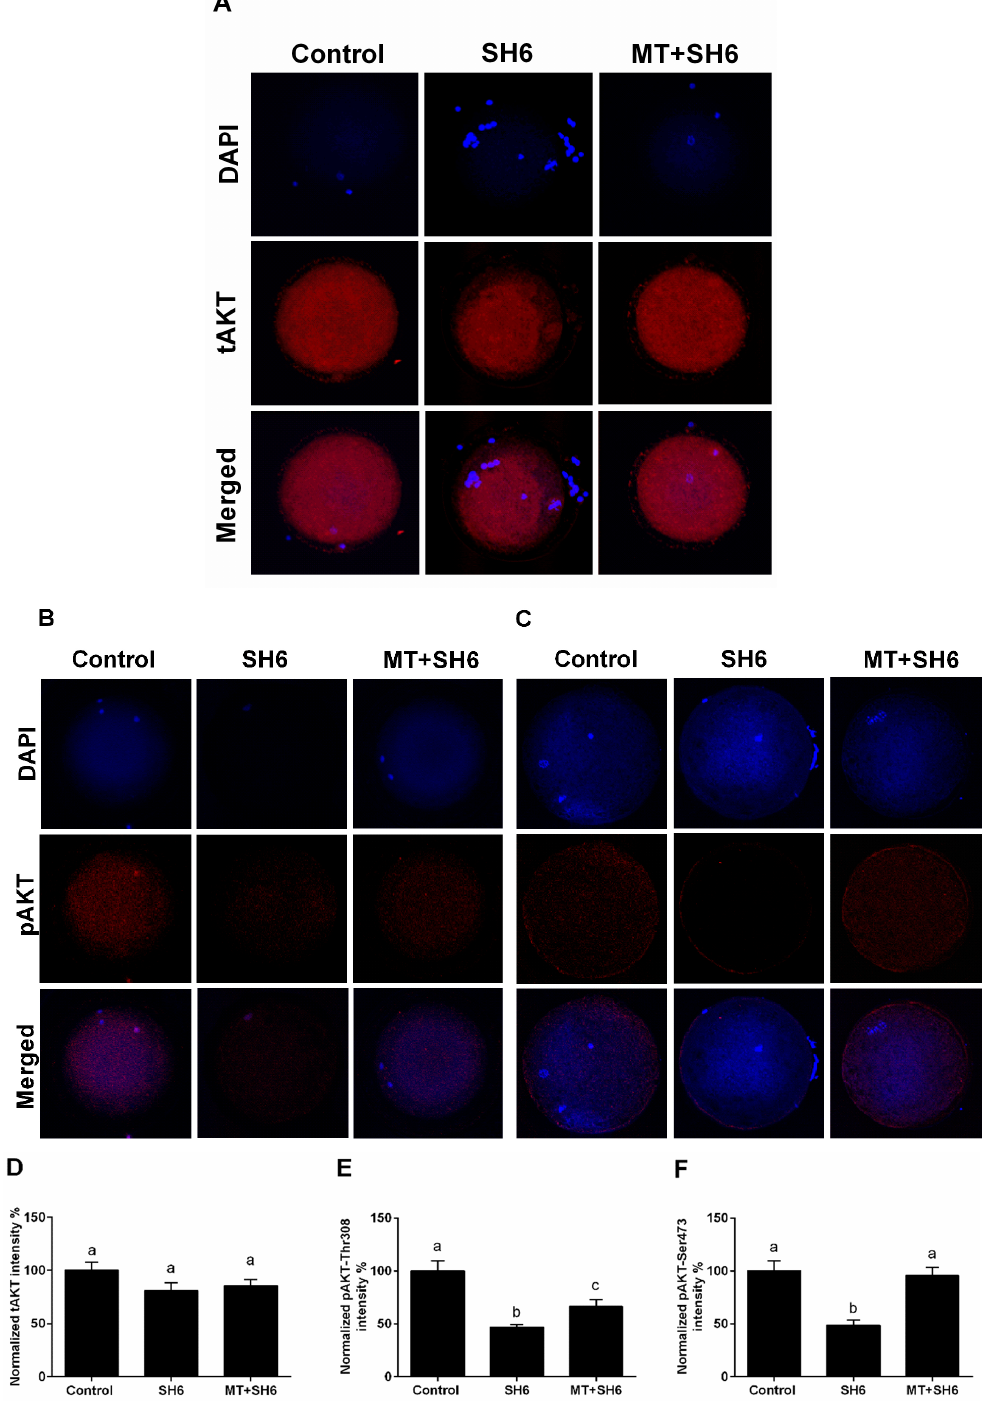
Figure 12. Immunofluorescence of total and phosphorylated AKT in oocytes. ( A ) Total AKT; ( B , C ) Phosphorylated AKT-Thr308 and AKT-Ser473 respectively; ( D – F ) Mean values of the integrated optimal densities of total and phosphorylated AKT. tAKT: total AKT; pAKT: phosphorylated AKT. Superscripts with di ff erent letters indicate statistical significance ( p < 0.05). Original magnification 100 ×